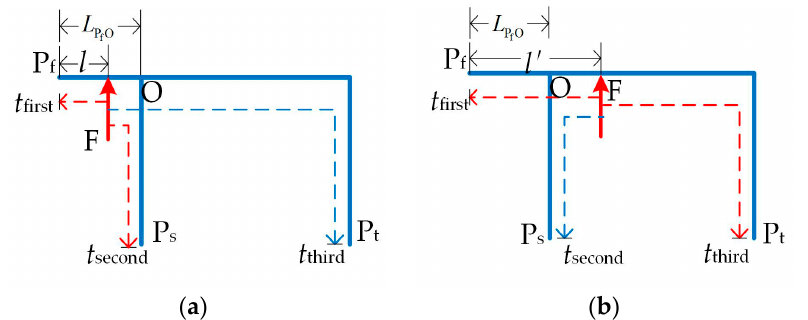
Figure 7. Three-terminal fault section separated from the multi-terminal lines. ( a ) Fault between P f and P s . ( b ) Fault between P f and P t .